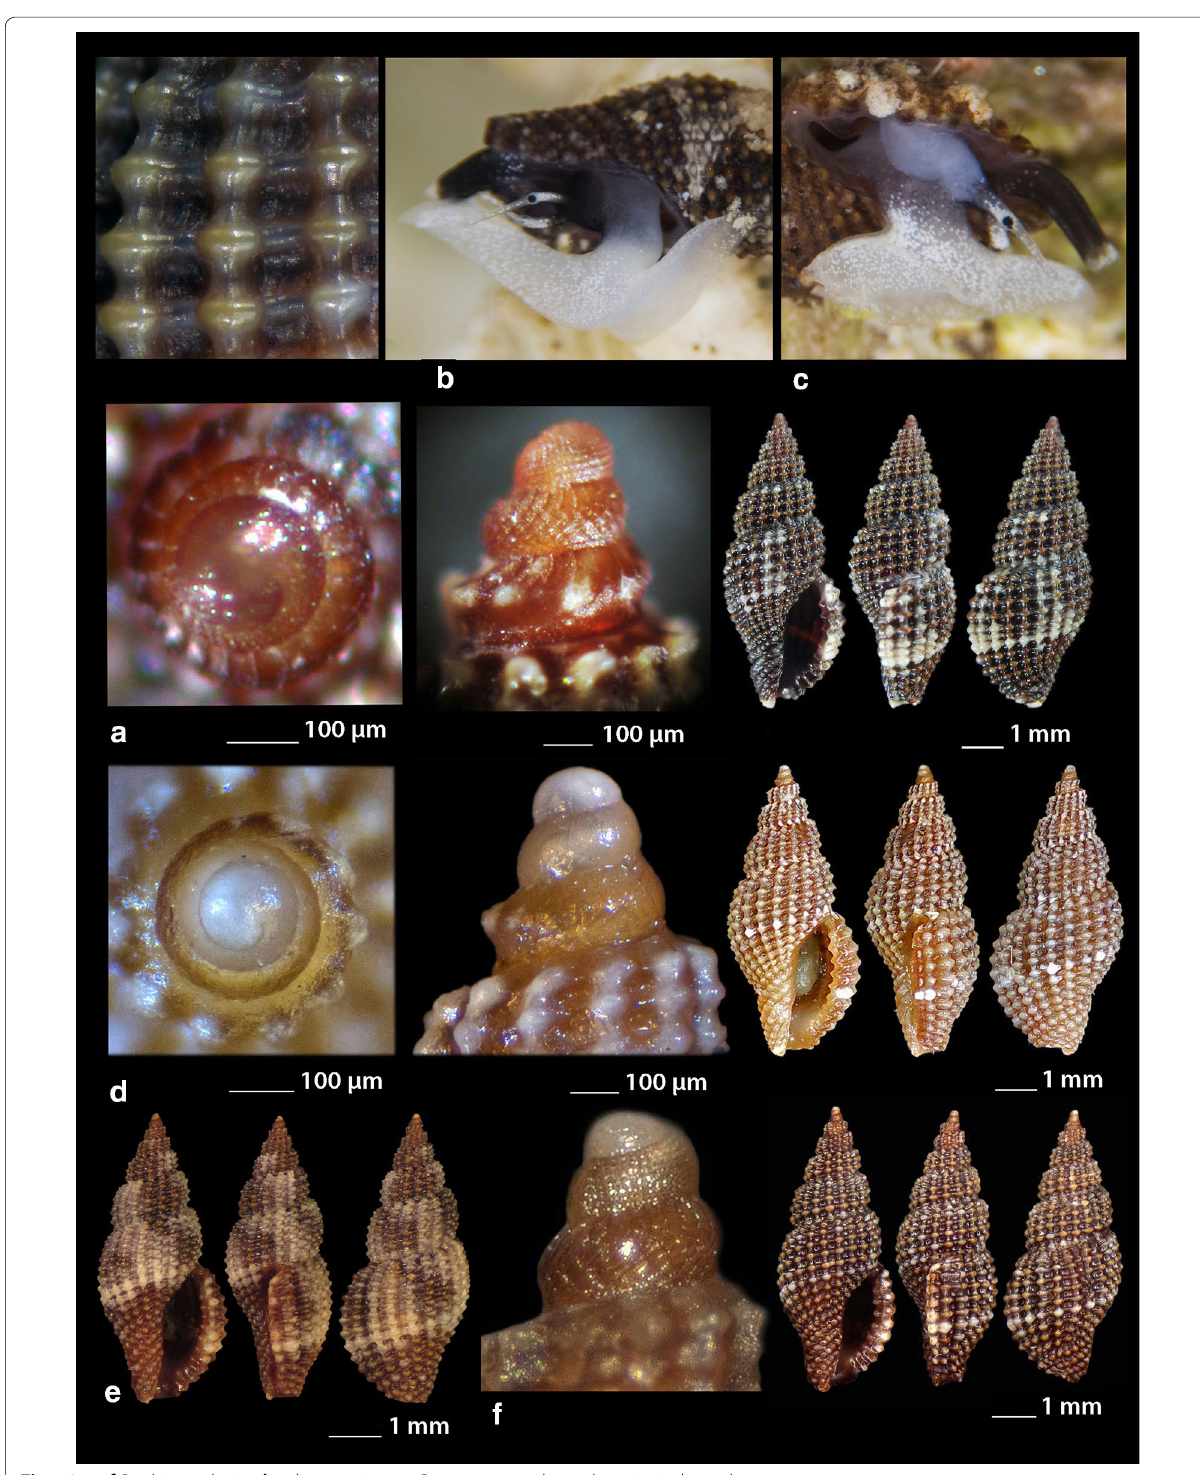
Fig. 13 a – f Raphitoma laviae , b , c live specimens. Bar